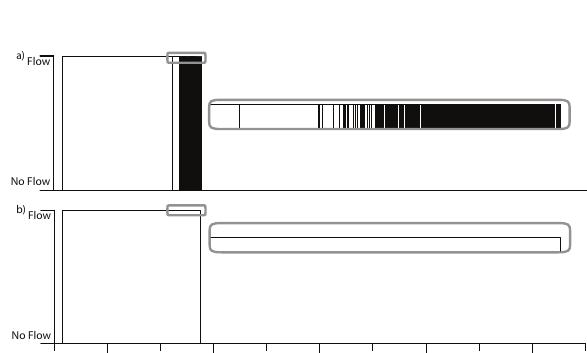
Fig. 4. Rondeau Bay study sites.